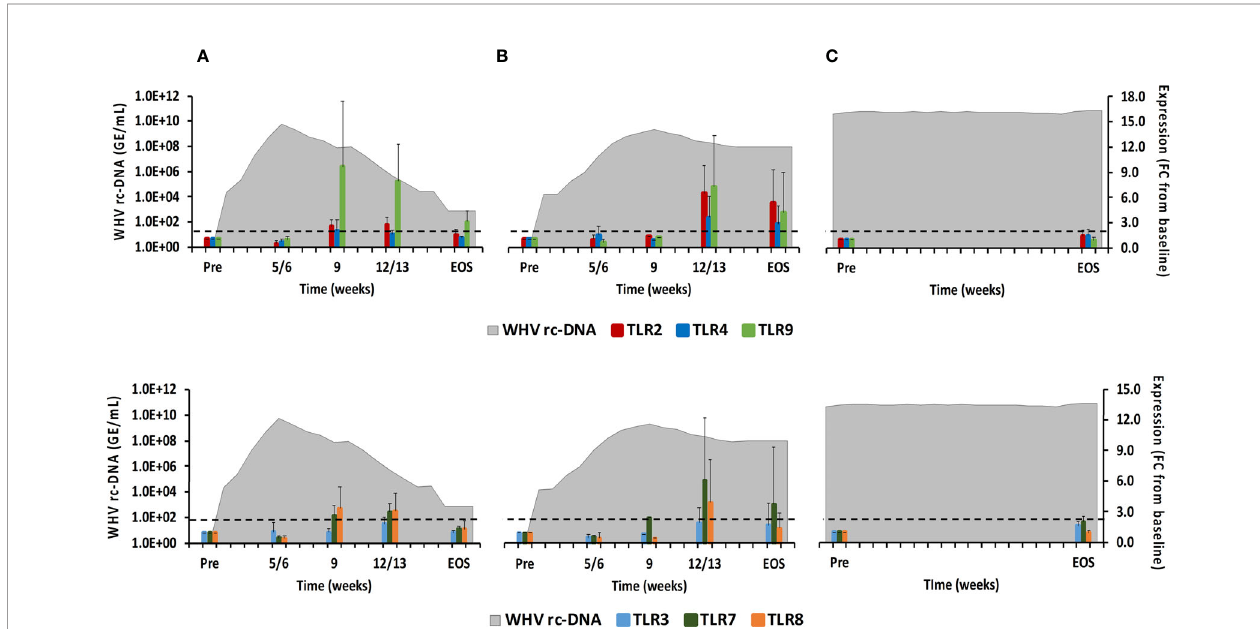
FIGURE 5 | Intrahepatic TLR expression. Expression changes of TLR2/4/9 (top panels) and TLR3/7/8 (bottom panels) in liver with WHV rc-DNA kinetics of woodchucks during (A) AHB with normal resolution (n=5), (B) AHB with delayed resolution (n=5), and (C) CHB progression (n=3). The fold-changes in receptor transcript level are plotted on the right y-axis, while serum WHV rc-DNA loads are plotted on the left y-axis. The horizontal, dotted line indicates the cutoff for positive expression (i.e., ≥ 2.1-fold increase from the pre-inoculation baseline). Horizontal bars represent the standard error of the mean. Pre, pre-inoculation for AHB and start of study for CHB; EOS, end of study; FC,